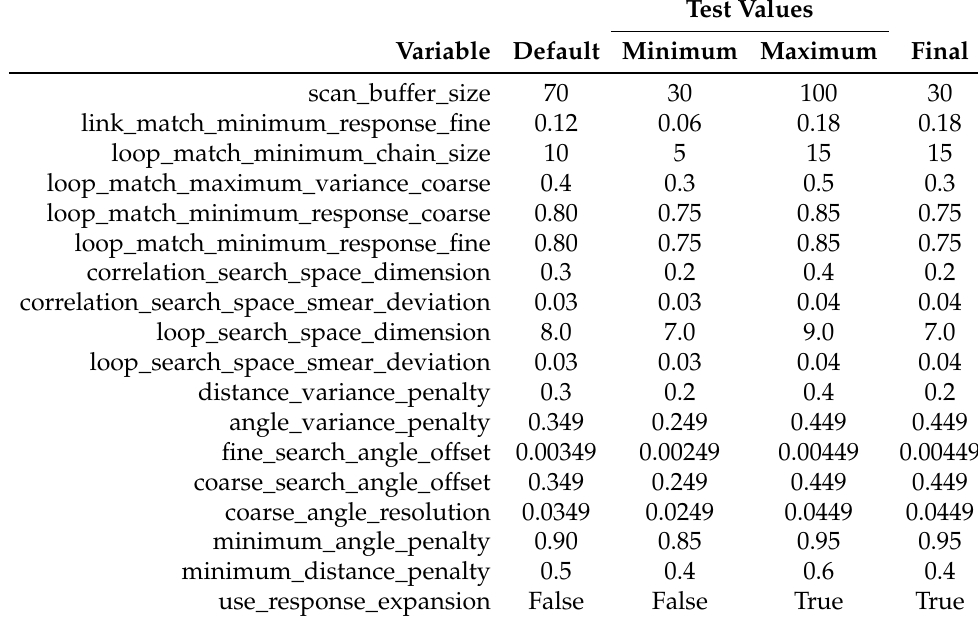
Table 9. Default, tuning and final values for